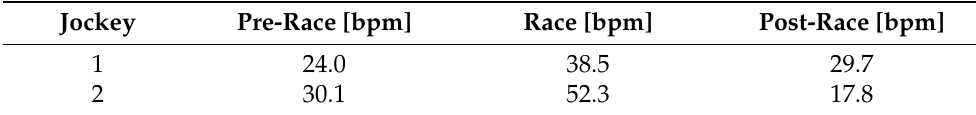
Table 2. Respiratory rate estimation in the different race